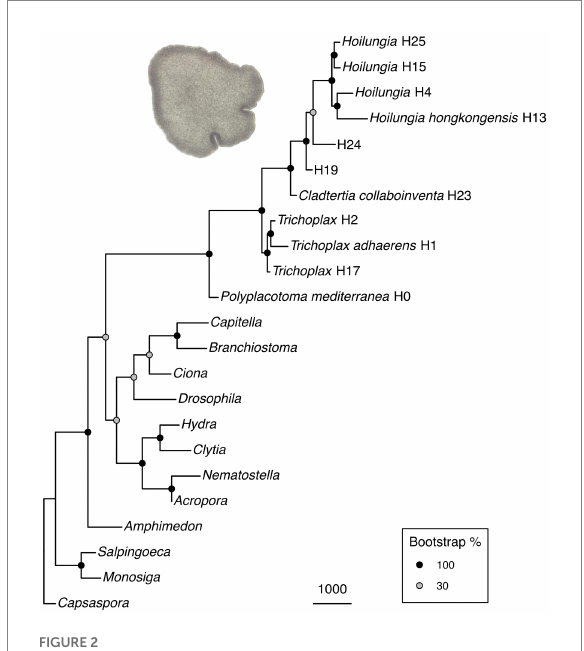
FIGURE 2 Parsimony reconstruction of most known clades of the phylum Placozoa using gene content (i.e., presence/absence) data for 15,849 genes. Only data from genomes with ≥ 90% BUSCO scores (complete + fragmented) were used for this analysis to avoid inflated absence data for lower-quality genomes. This removed placozoan lineages H6 and H11, as well as the ctenophores ( Mnemiopsis and Pleurobrachia ) and a sponge ( Oscarella ). The image is Trichoplax adhaerens (displays the typical morphology known for Placozoa lineages other than Polyplacotoma